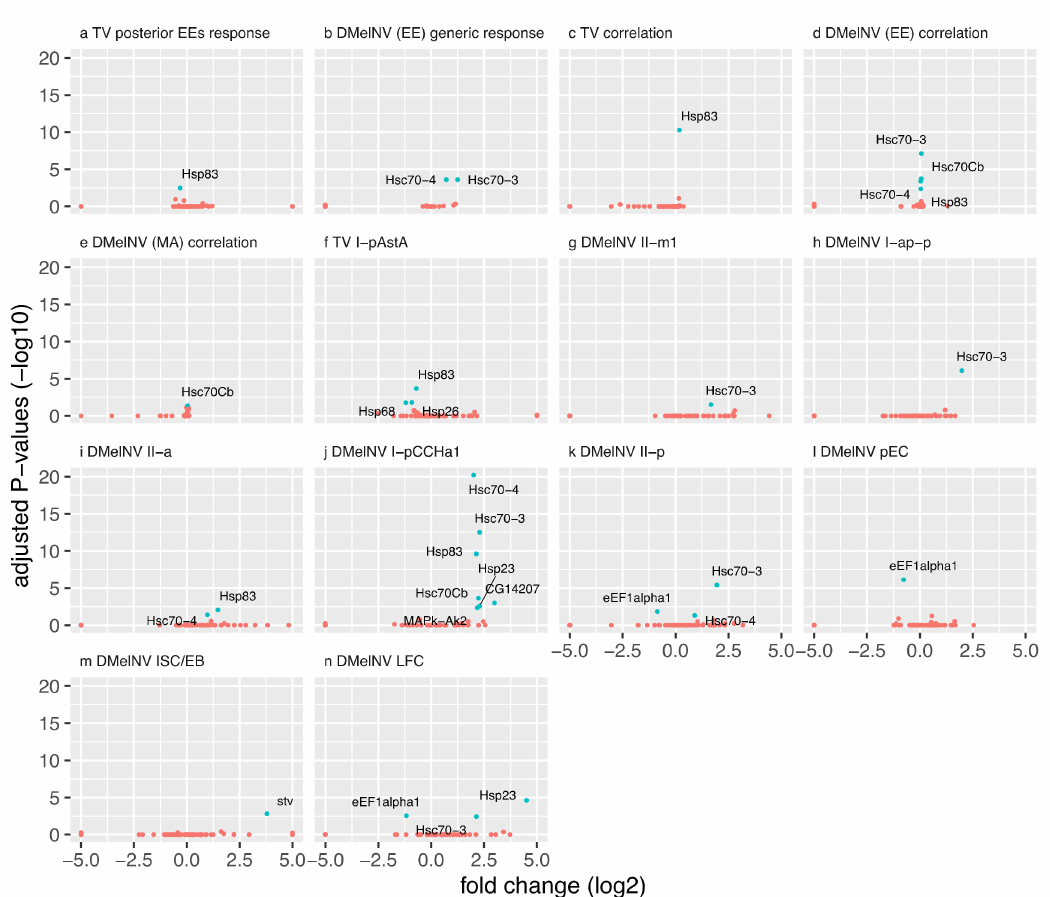
Figure 4. ( a – n ) Volcano plots of genes associated with heat shock response. Each panel correspond to a differential expression test where at least one gene associated with cellular response to heat stress (Reactome pathway: R-DME-3371556) was differentially expressed (adjusted p < 0.05). These genes are highlighted in blue. Log 2 -fold changes of genes that expression correlate to viral RNA accumulation correspond to the expected increase in gene expression when the viral percentage increases by one